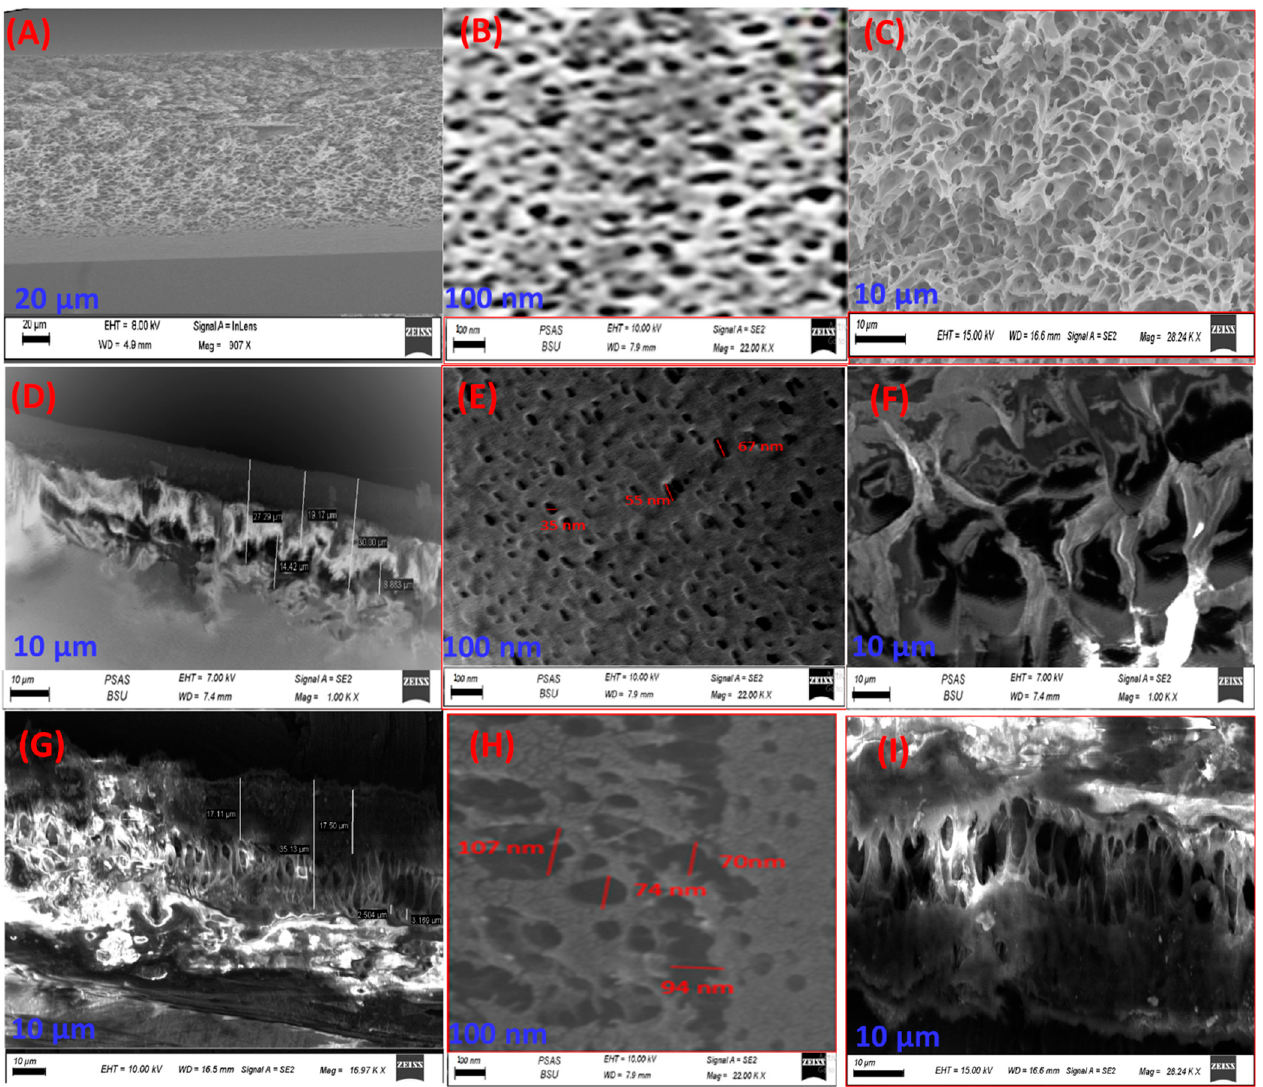
Figure 2. Cross-sectional SEM micrographs for ( A – C ) pure PES, ( D – F ) PES-0.7GO, and ( G – I ) PES- 0.7TNR membranes.